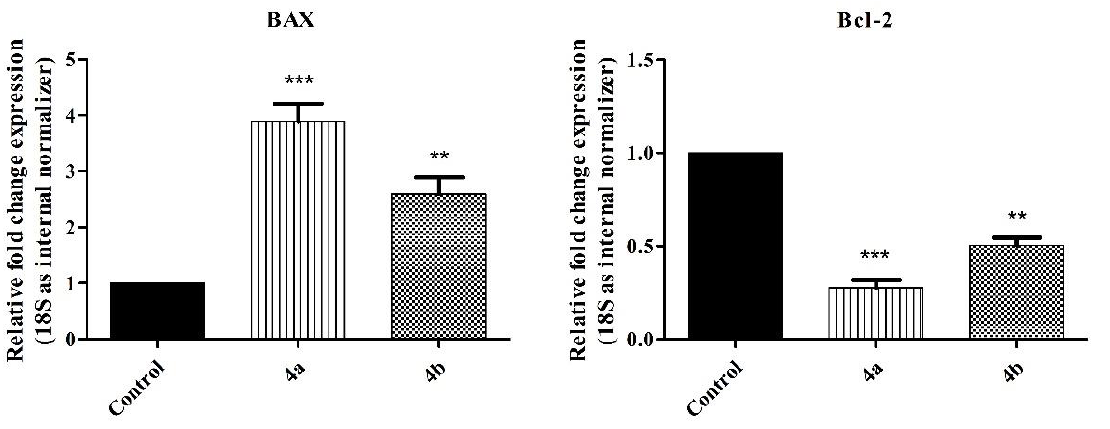
Figure 6. The difference in Bcl − 2 and BAX mRNA expressions in RPMI − 7951 cells following treatment with 4a and 4b (tested at IC 50 : 18.8 µ M and IC 50 : 20.7 µ M) for 48 h. The fold change expressions were compared to 18S RNA, while DMSO acted as the control. All experiments were performed in triplicate and the results were reported as mean values ± SD. Statistical differences vs. DMSO stimulated cells were determined using one − way ANOVA with Dunnett’s post − test (** p < 0.01 and *** p < 0.001).